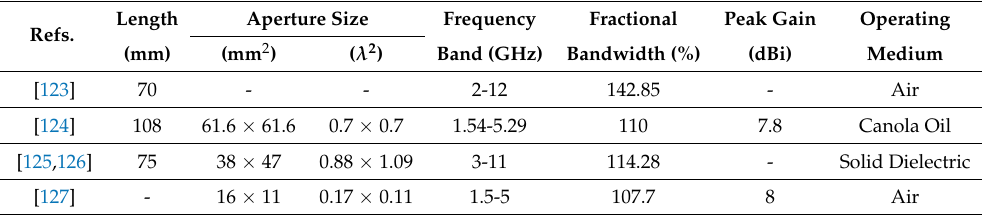
Table 6. Comparative analysis between horn antennas for microwave imaging applications.